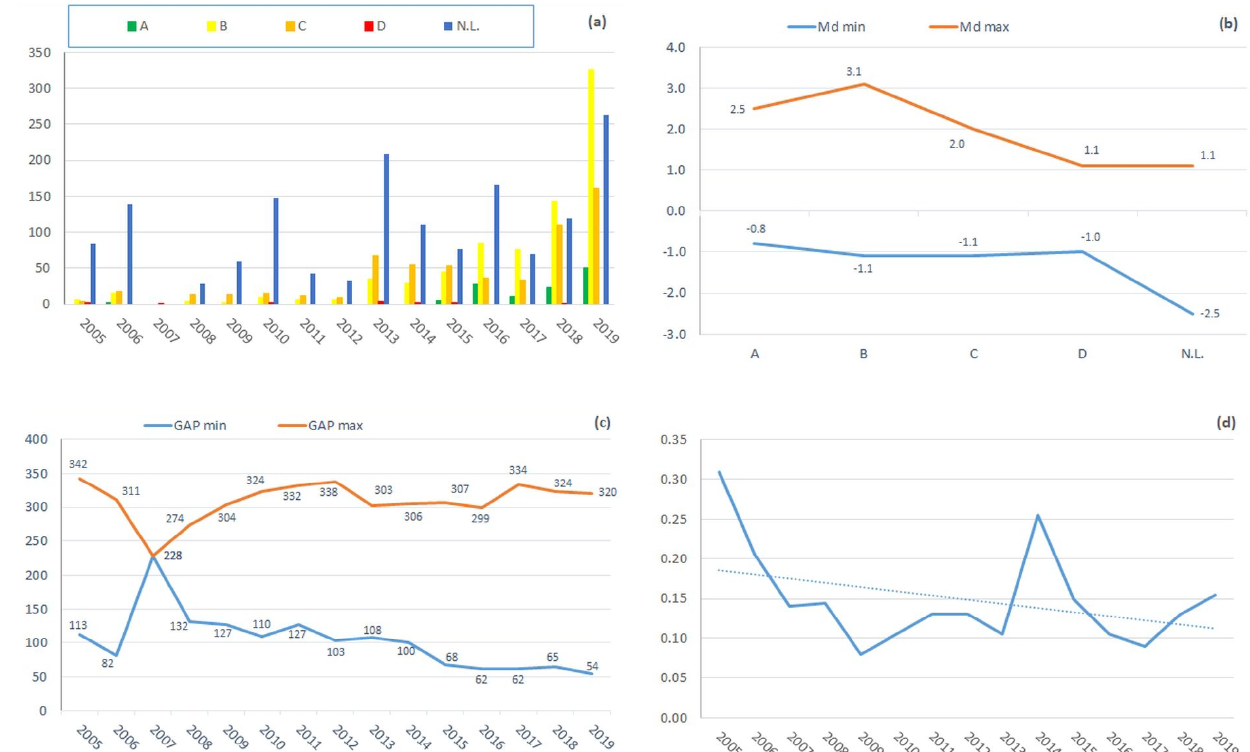
Figure 4. Location quality patterns. (a) VT earthquake time distribution for the location quality parameters ( A , B , C and D ) and time distribution of N.L. VTs; (b) Max and min M d distribution over location quality parameters and N.L. category; (c) Max and min GAP distribution over time; (d) Mean RMS distribution over time (continuous blue line) and trend (dotted blue